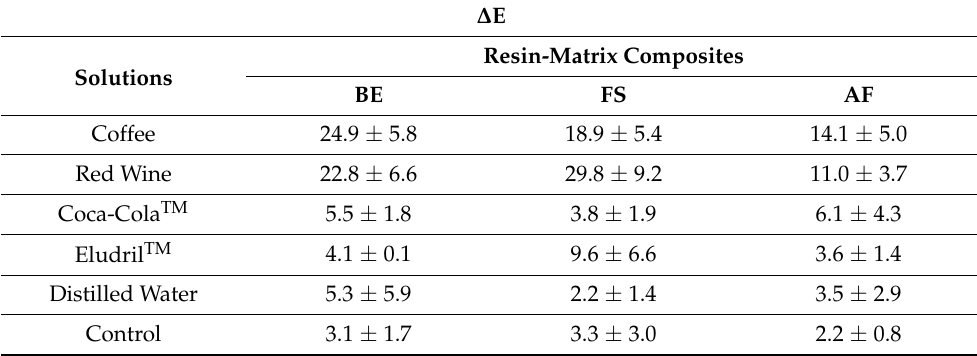
Table 3. Mean ± standard deviation values recorded for CIE L*a*b*, before and after immersing the specimens in the coffee solution.